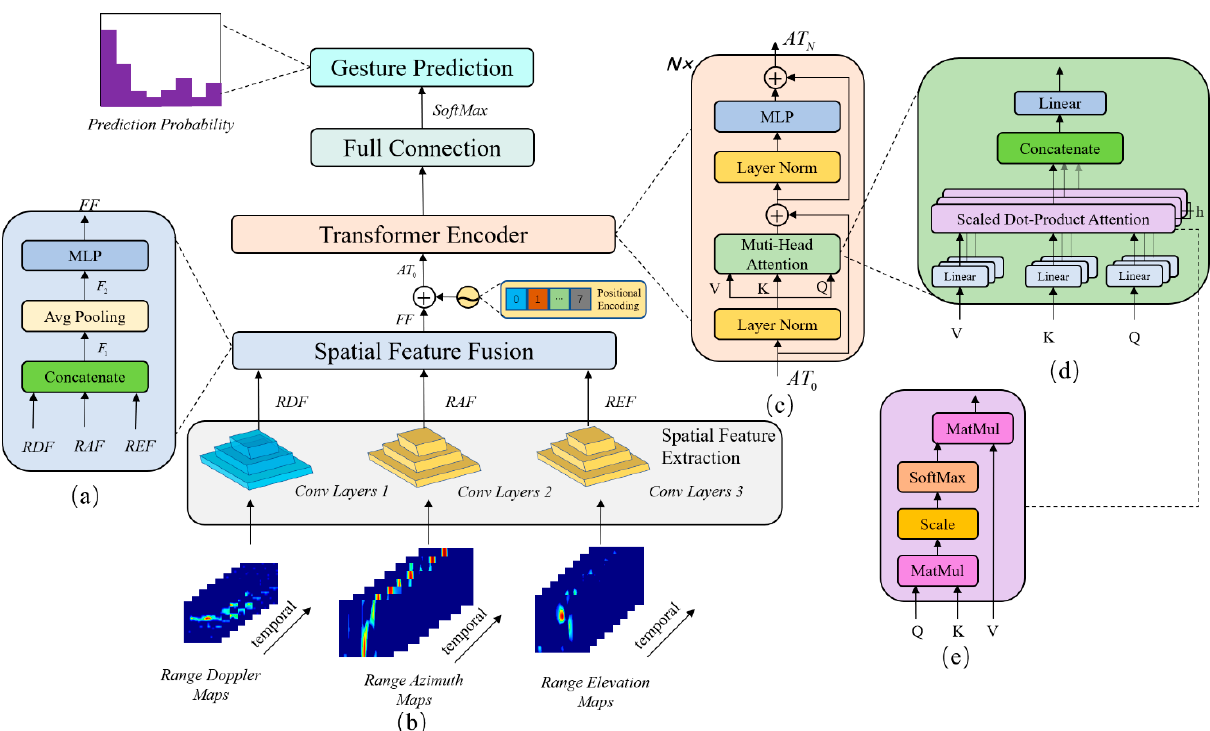
Figure 12. The architecture of RGTNet. ( a ) is the structure of spatial feature fusion module. ( b ) is the overall architecture of RGTNet. ( c ) is the structure of Transformer encoder. ( d ) is the structure of multi-head attention module. ( e ) is the calculation flow of scaled dot-product attention.